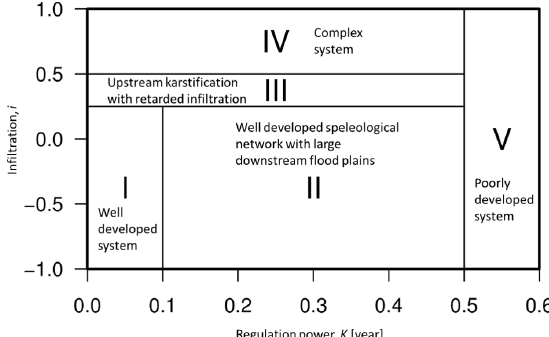
Figure A1. The Mangin (1975) karst system classification scheme based on K and i